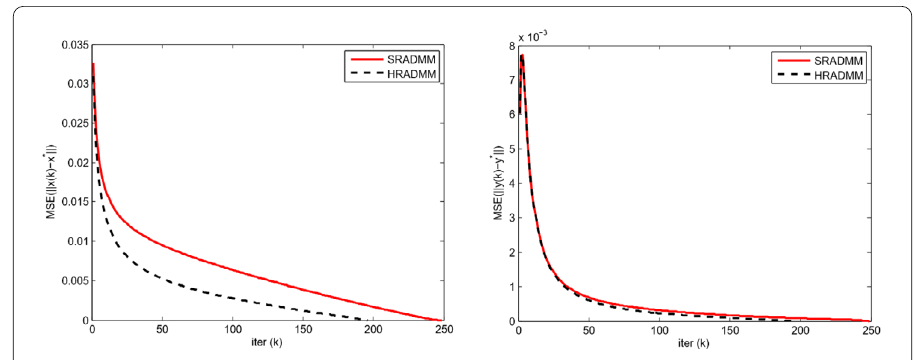
Figure 1 Comparison the performance of HRADMM and